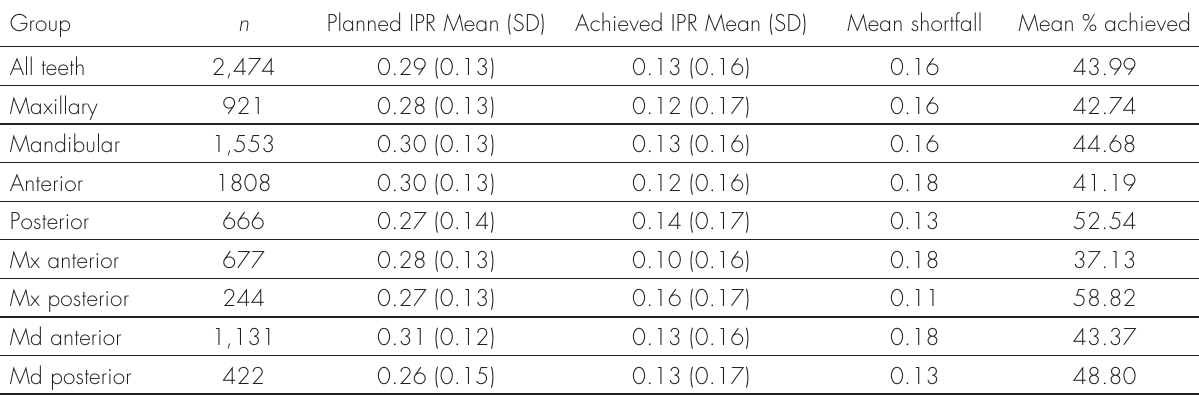
Table VII. Mean planned and achieved IPR (in mm) by